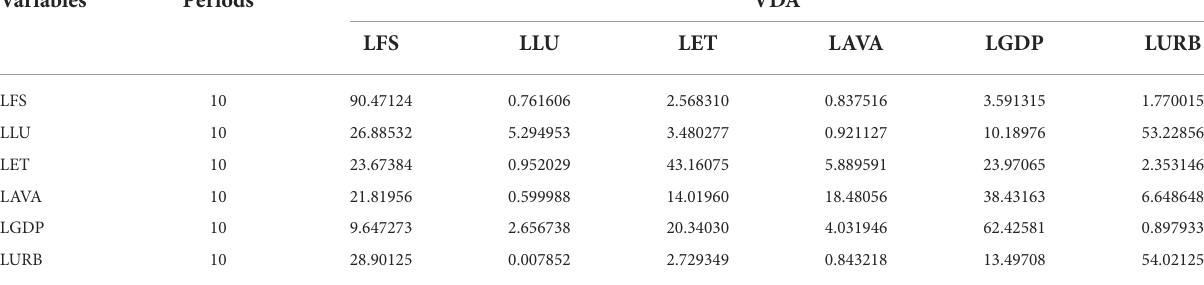
TABLE 8 comes of variance decomposition analysis